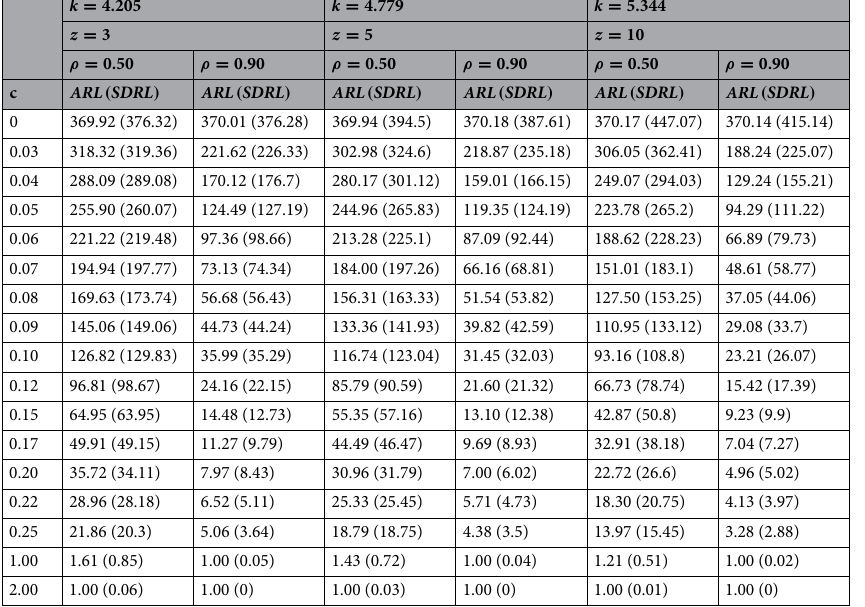
k = 4.205 k = 4.779 k =